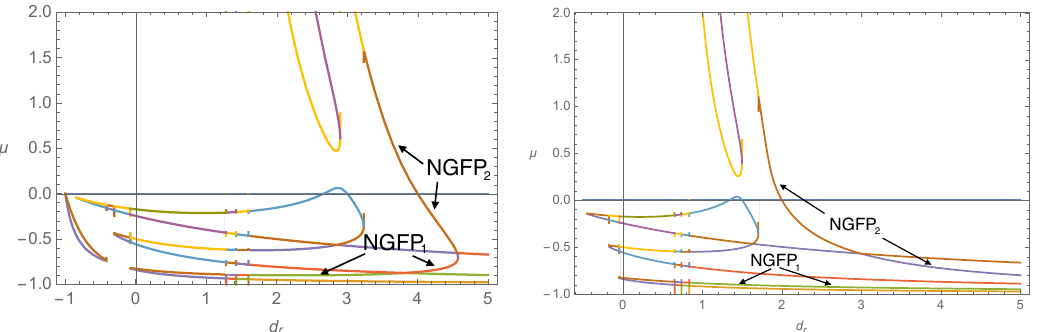
Figure 4 . Fixed point value ¯ µ ∗ as a function of the UV dimension d r at truncation order n = 4 for ζ = 1 (left) and ζ = 1 / 2 (right). The NGFP candidates lie on the solution branch which has ¯ µ = 0 at the critical dimension d r = d crit . This curve turns (has a branching point) for ζ = 1 at d • ≈ 4 . 5 while for ζ = 1 / 2 we find this point at d • ≈ 103